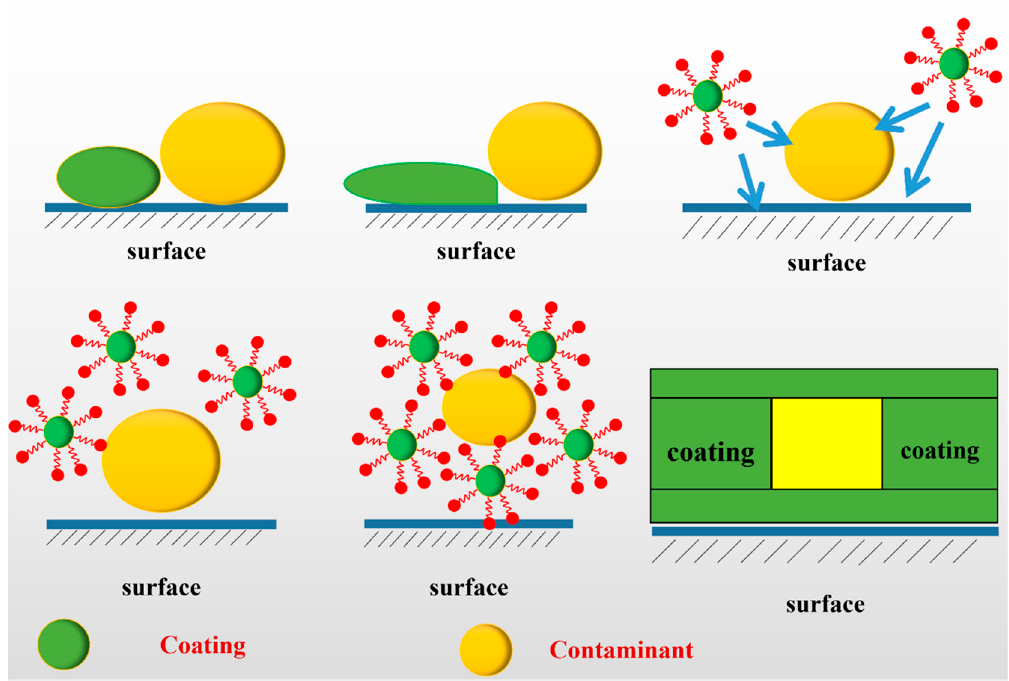
Figure 6. Action mechanism of decontaminant particles and pollutants.